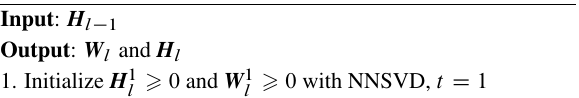
Table 1 Algorithm 1. Algorithm 1 Optimal gradient method for initialization